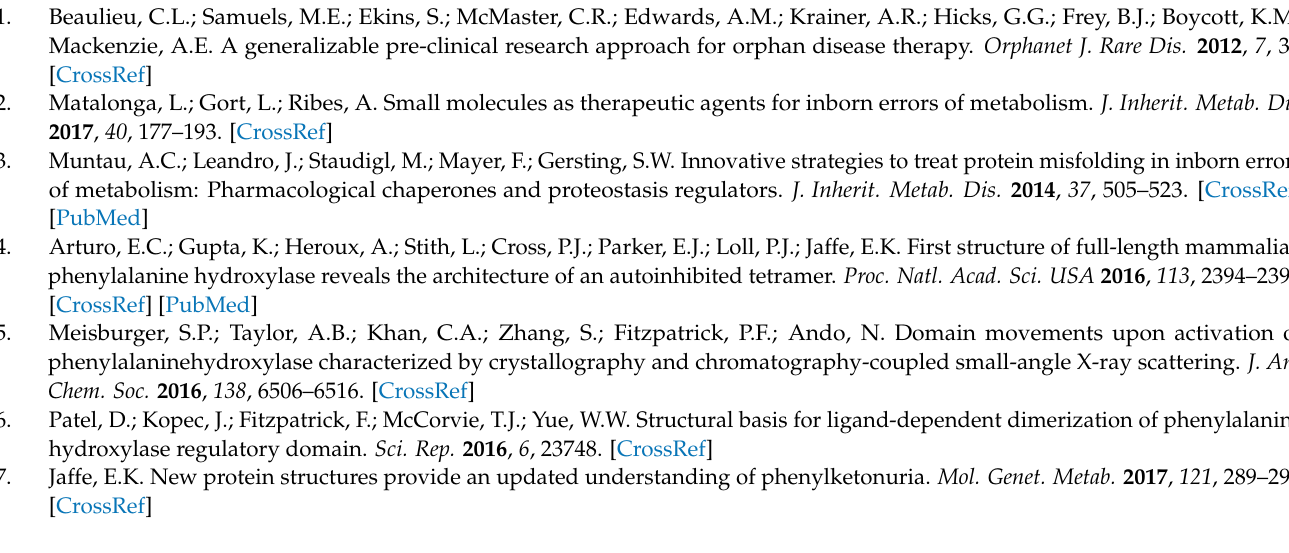
compounds, Table S4: Calculated distances (Å) of the selected 3HQs to the catalytic non-heme iron and its ligands (His285, His290 and Glu330), and to specific amino acid residues that interact with catecholamines reversible inhibitors (Phe254, Tyr325 and Glu330), Table S5: Calculated distances (Å) of the selected 3HQs to specific amino acid residues, involved in cofactor (BH 4 ) and substrate ( L